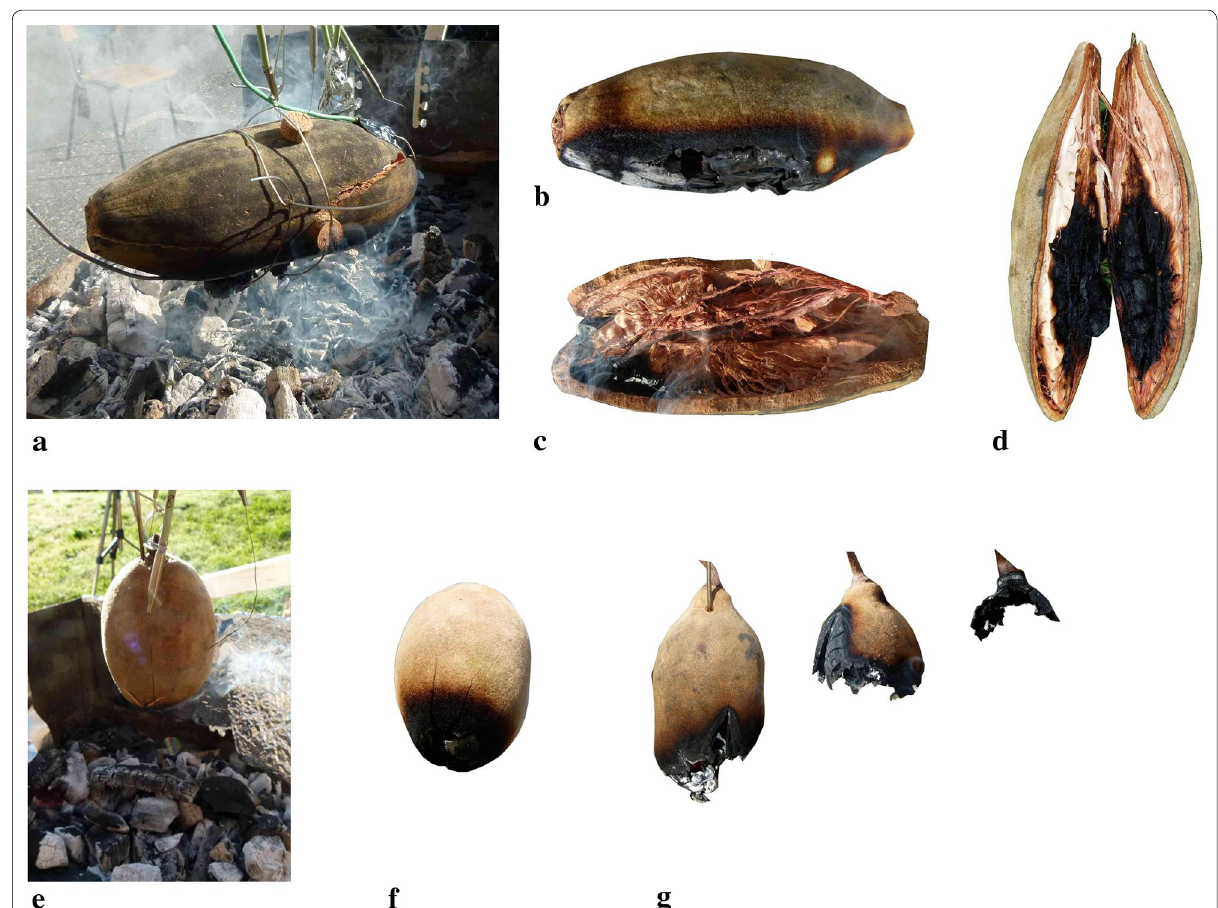
Fig. 2 a A. digitata above glow with cracked shell by heat. b Decomposed fire-facing side after test. c Same fruit, view inside after test less than 10 min above glow with partly unburned and browned pulp. d Another fruit opened with heavily smouldered parts after test more than 10 min above glow. e A. gregorii above glow. f Same fruit, fire facing side after test. g Another fruit, in one case, ongoing smouldering of fruit shell (heat source was already removed) with successive shell decomposition and complete loss of seeds. All scale bars 50 mm